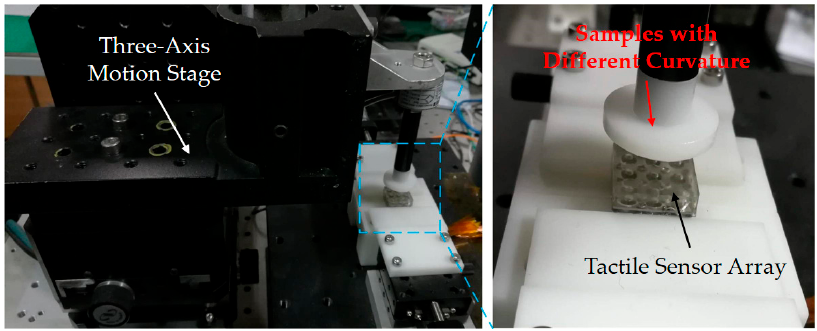
Figure 7. Automatic contact loading test platform for object curvature discrimination.